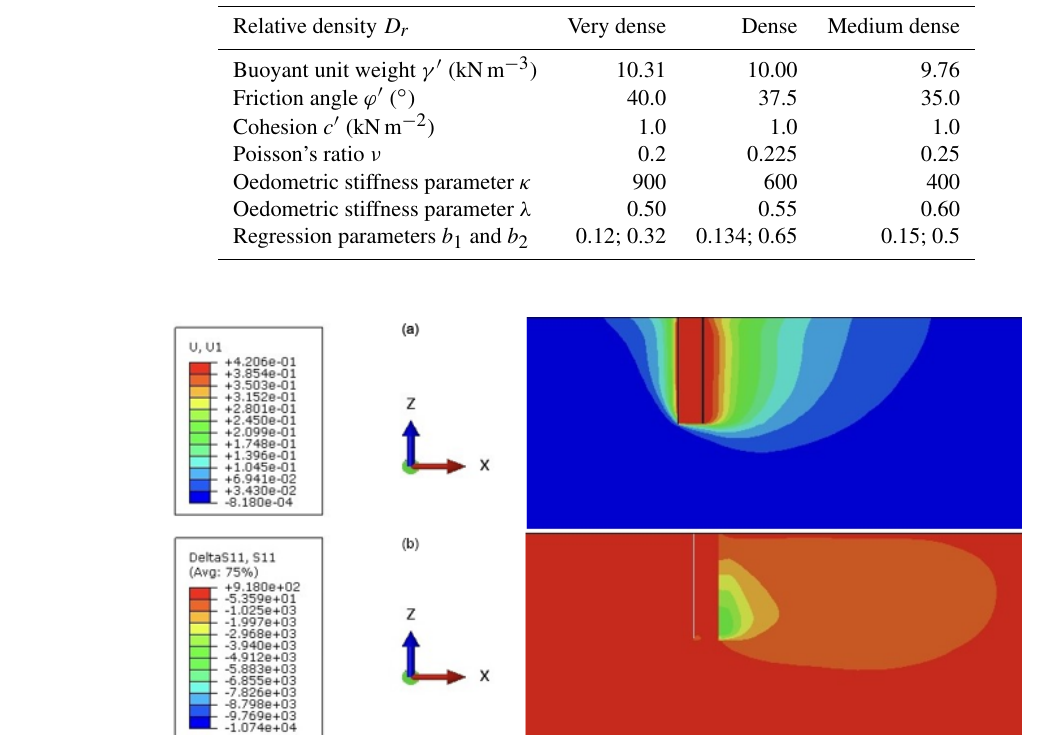
Figure 4. Horizontal displacements (a) and stresses (b) for a monopile D = 5m under static load in very dense sand ( N = 1, prescribed pile displacement y = 0.42m).